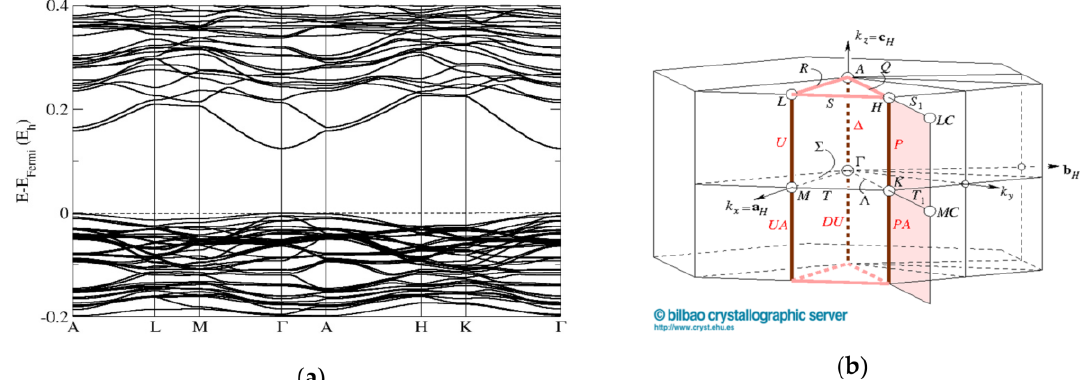
Figure 8. Band structures ( a ) of the wurtzite ZnO 0.813 S 0.187 supercell model computed using the PBE0 functional with undistorted hexagonal (P6 3 mc) symmetry and ( b ) corresponding directions in the Brillouin zone (https://www.cryst.ehu.es/cryst/get_kvec.html, accessed on 6 November 2022). Moreover, we show the predicted band structures of the wurtzite ZnO 0.813 S 0.187